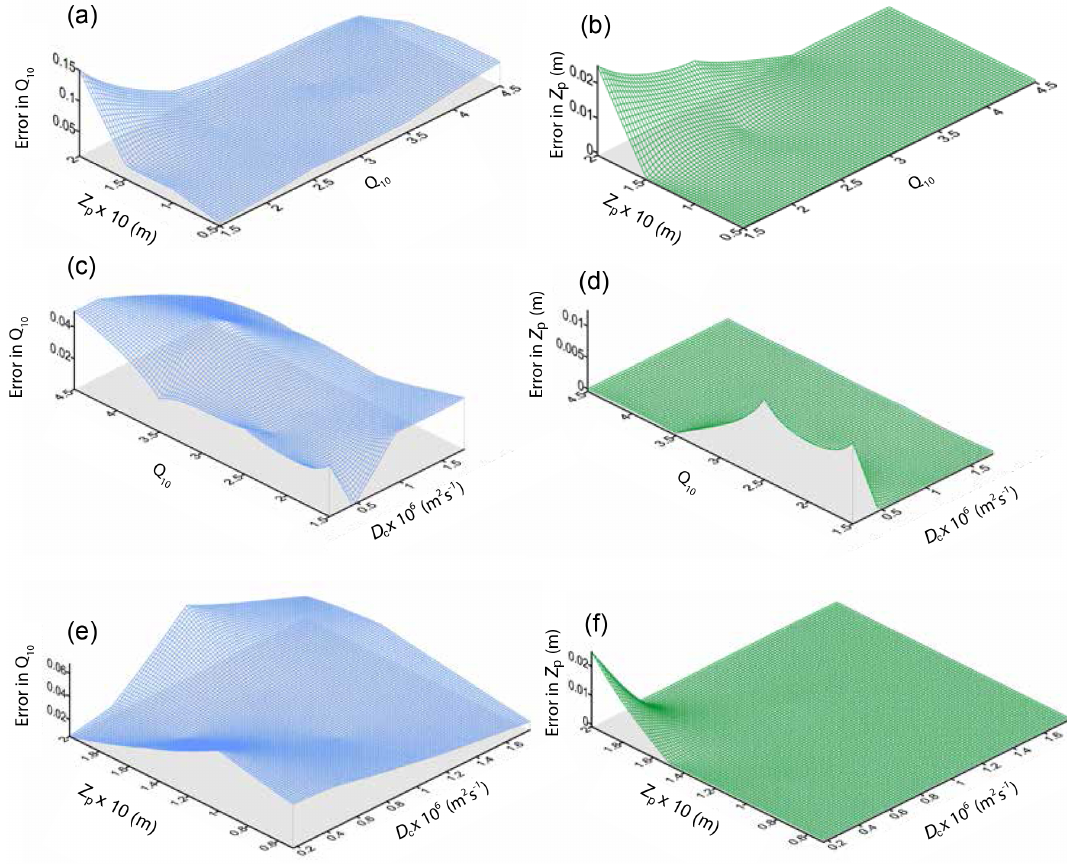
Figure 6. Error in Q 10 and Z p as a function of Q 10 , Z p , and diffusivity for the constraint 5 + 10 + 15cm. For these sensitivity tests, the known Q 10 was 2.0, and a Z p of 0.2m was